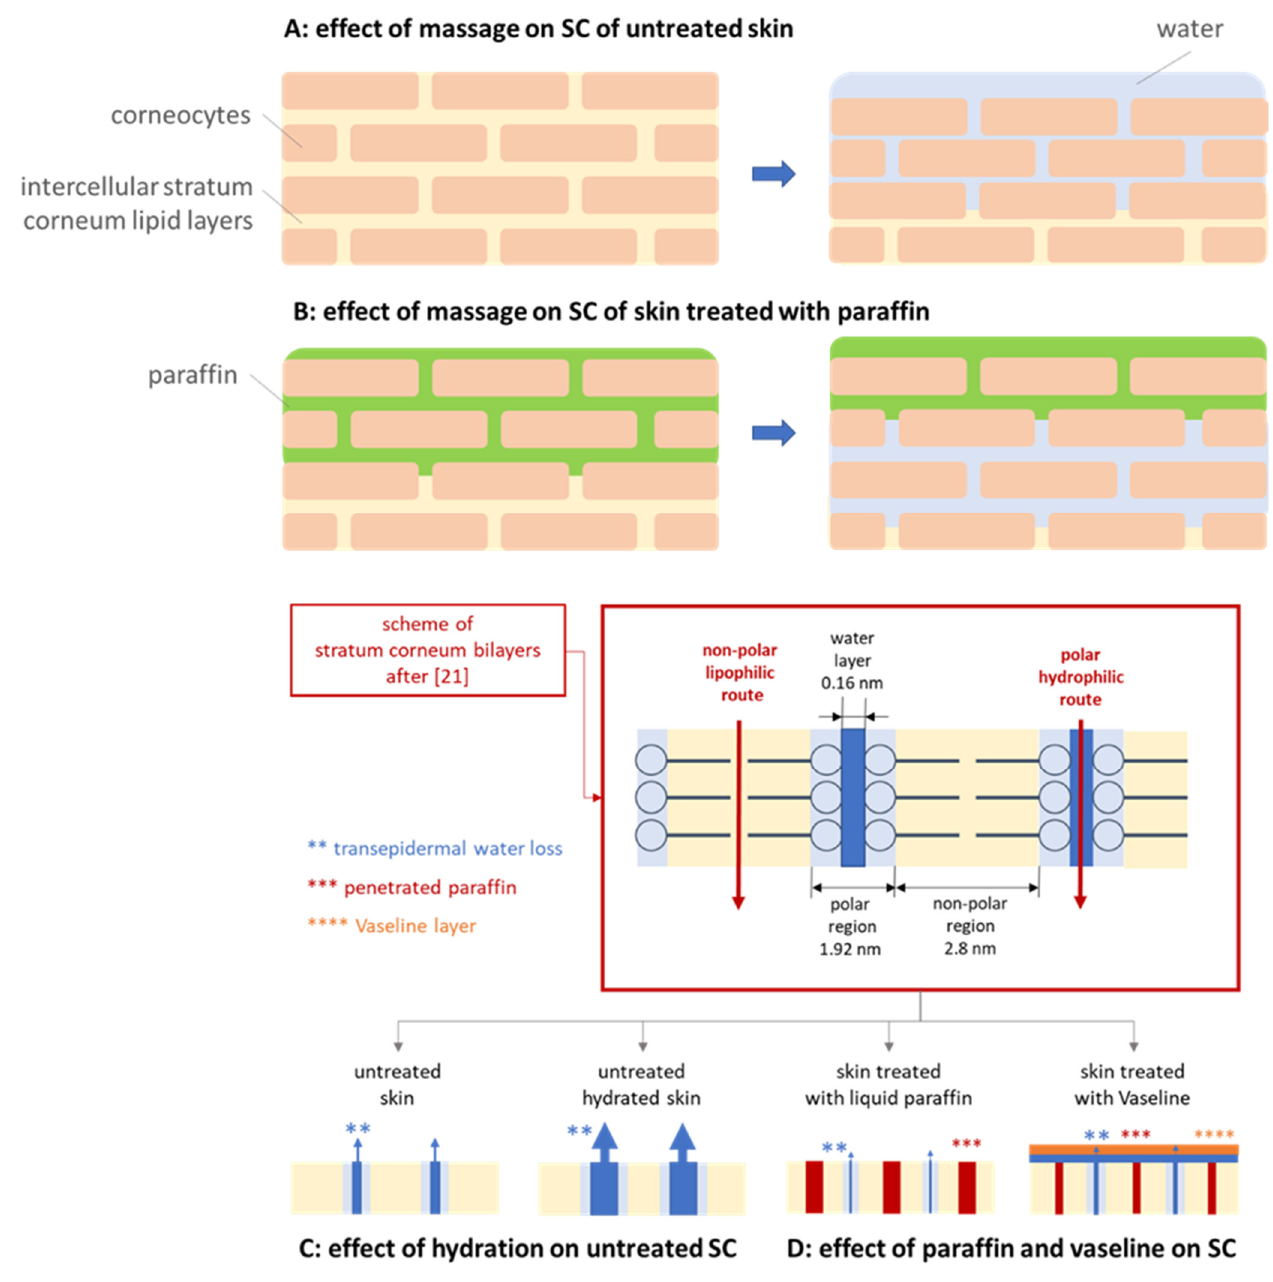
Figure 9. Scheme visualizing the effect of massage, occlusion, and direct hydration on the SC (explanation cf. text). The application of paraffin onto dry skin with massage—when compared to the application of paraffin without massage—increased the free water on top of the skin (+7%), decreased the free water in the lower SC ( − 8%), and increased the bound water (approx. +30%). The observed effects indicate that the squeeze-out effect that was already